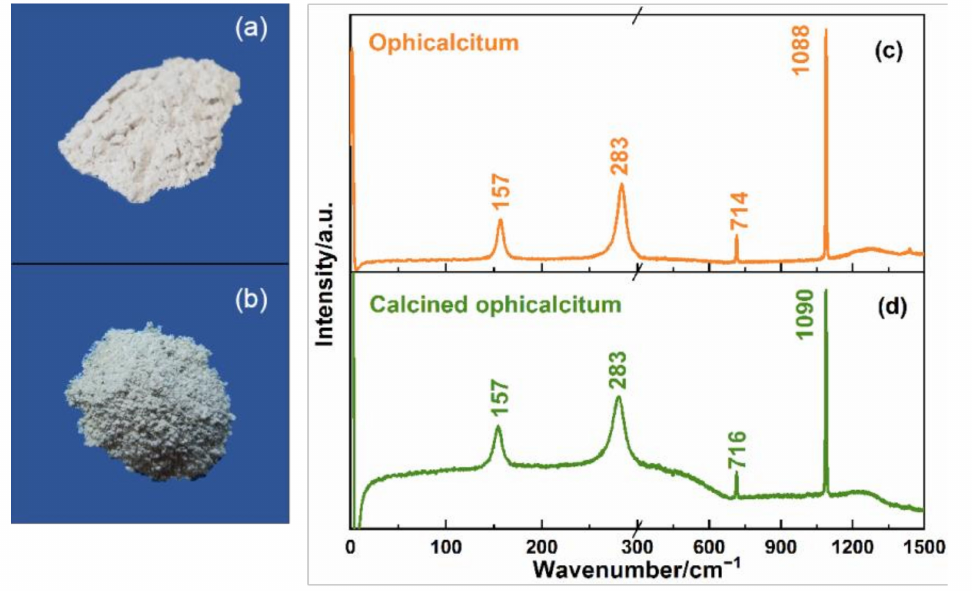
Figure 6. ( a ) Ophicalcitum, ( b ) calcined ophicalcitum, and the Raman spectra of ( c ) ophicalcitum and ( d ) calcined